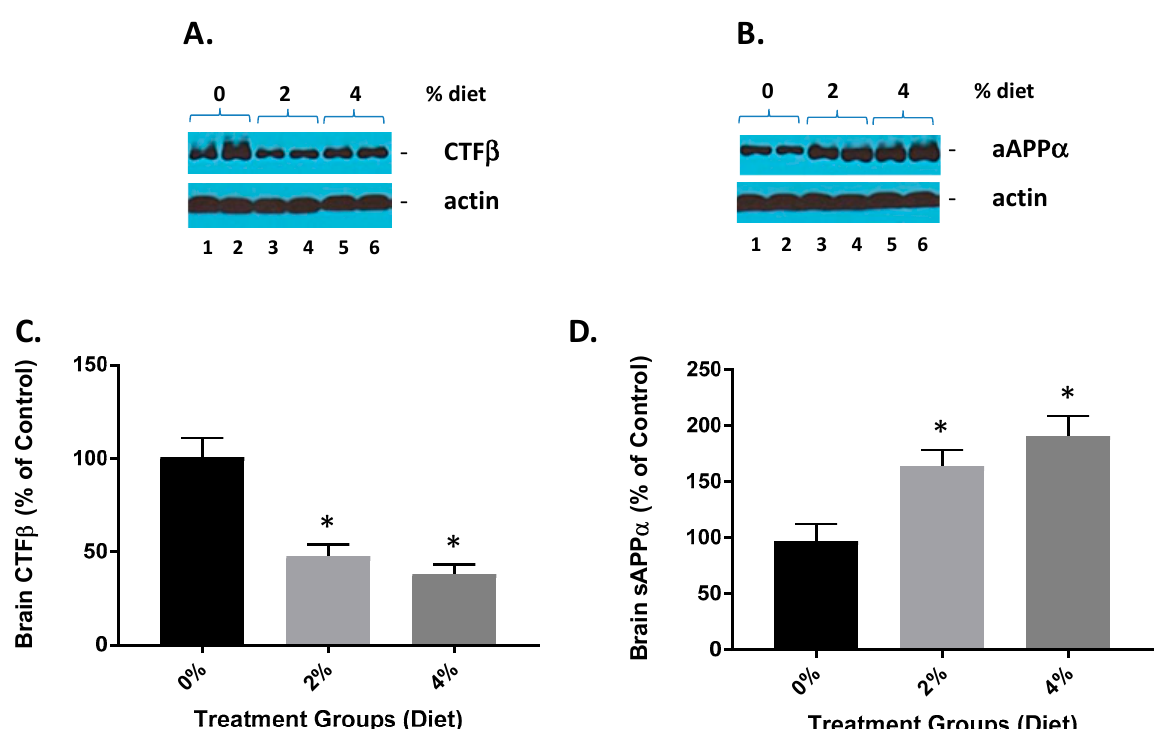
Figure 2. GF diets lower and increase brain CTF β and sA β PP α . ( A ) GF diets caused a reduction in brain CTF β . ( B ) GF diet mediated increase in brain sA β PP α levels. ( C , D ). Quantification of blots from ( A , B ), respectively. These data are consistent with GF diets mediating the inhibition of β -secretase activity because sA β PP α is derived from A β PP α -secretase cleavage, which competes with β secretase cleavage of A β PP, and thus the inhibition of β -secretase activity provides more A β PP for β -secretase to produce more sA β PP α (* p < 0.001; n = 20).